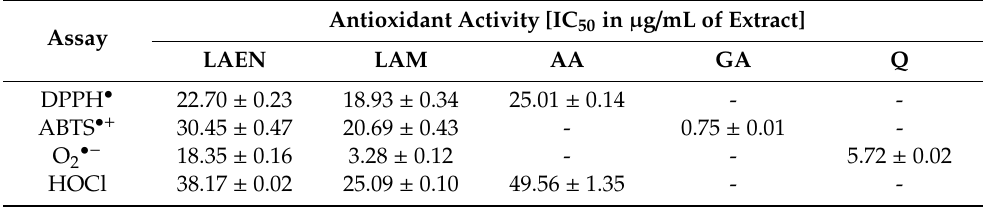
Figure 10. Scavenging effects of the etheric (LAEN) and methanolic (LAM) on hypochlorous acid (HOCl)-mediated oxidation of 5-thio-2-nitrobenzoic acid (TNB). Data are expressed as means ± SEM, obtained in at least three independent experiments, and assayed in triplicate. Statistical significance of differences was calculated between both extracts; * p < 0.05. Table 6. The IC 50 values established in antioxidant assays. Data are expressed as mean ± SEM, n = 3. AA—ascorbic acid, GA—gallic acid, Q quercetin.